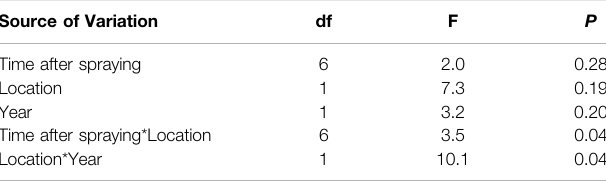
TABLE 2 | Results of repeated measures general linear model of factors affecting abundance of wasps per day on sticky traps. Source of Variation df F P Time after spraying